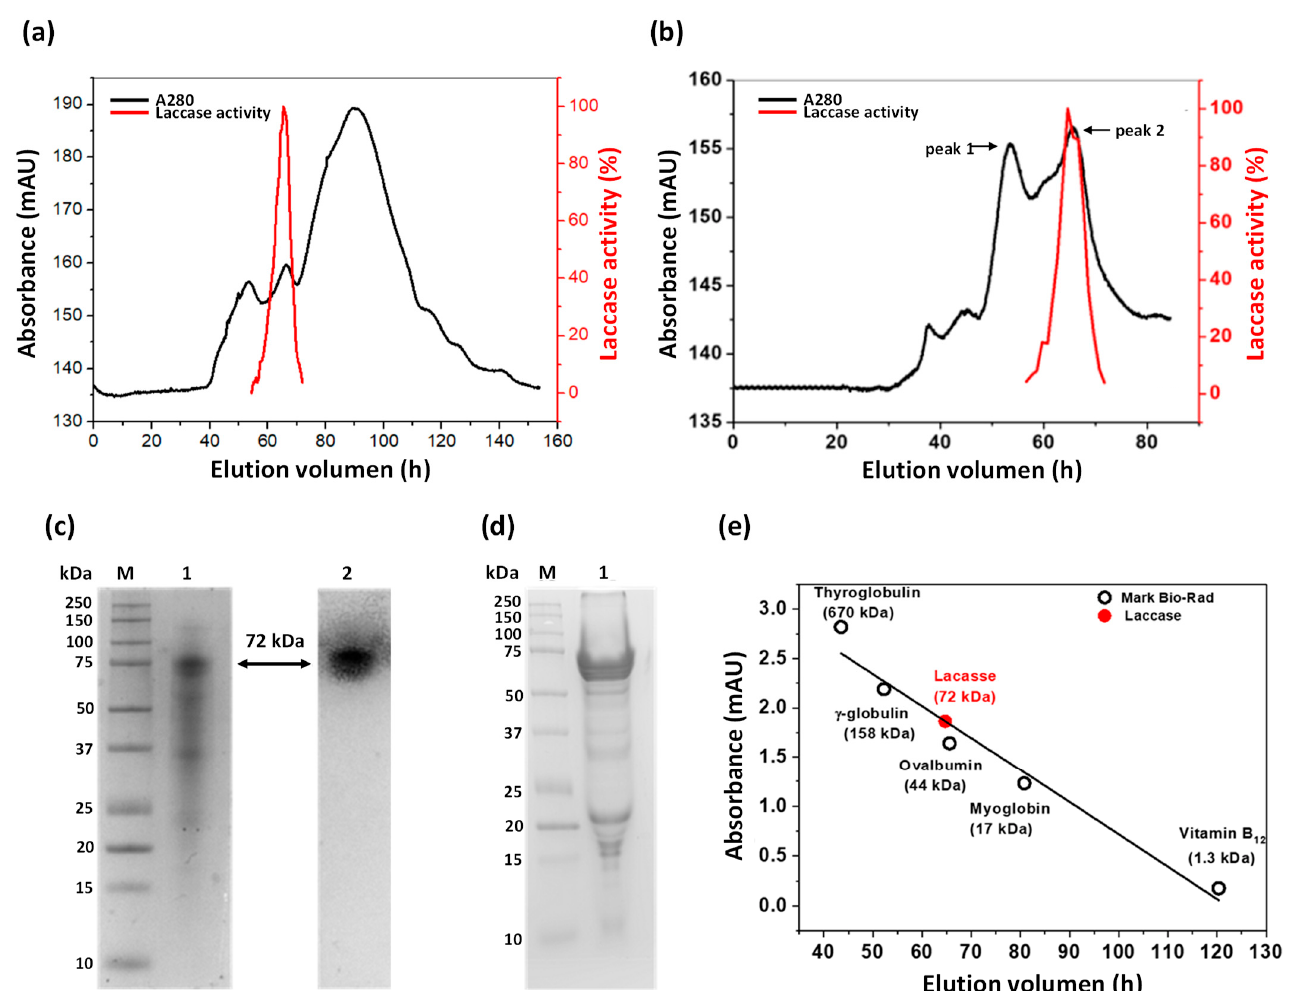
Figure 3. Purification of laccase enzyme produced by A . pediades . ( a , b ) Chromatogram of the proteins separated by the Sephacryl 200 exclusion column (black line). Laccase activity of the fractions (red line). ( c ) Semi-denaturing SDS–PAGE of the purified laccase enzyme. Lane 1: Purified laccase enzyme. Lane 2: Confirmation of laccase production by zymogram analysis using 2,6-DMP (2 mM) as substrate; 40 μ g of total protein was loaded into each lane. ( d ) Denaturing SDS–PAGE gel. Lane 1: Purified laccase enzyme incubated with β -mercaptoethanol (10 μ g of total protein). M: Protein molecular weight (MW) marker precision plus protein kaleidoscope. ( e ) Calibration plot showing the elution volumes of the Bio–Rad gel filtration standard (black spots) versus the log of the molecular weight (MW) of the laccase protein (red spot).